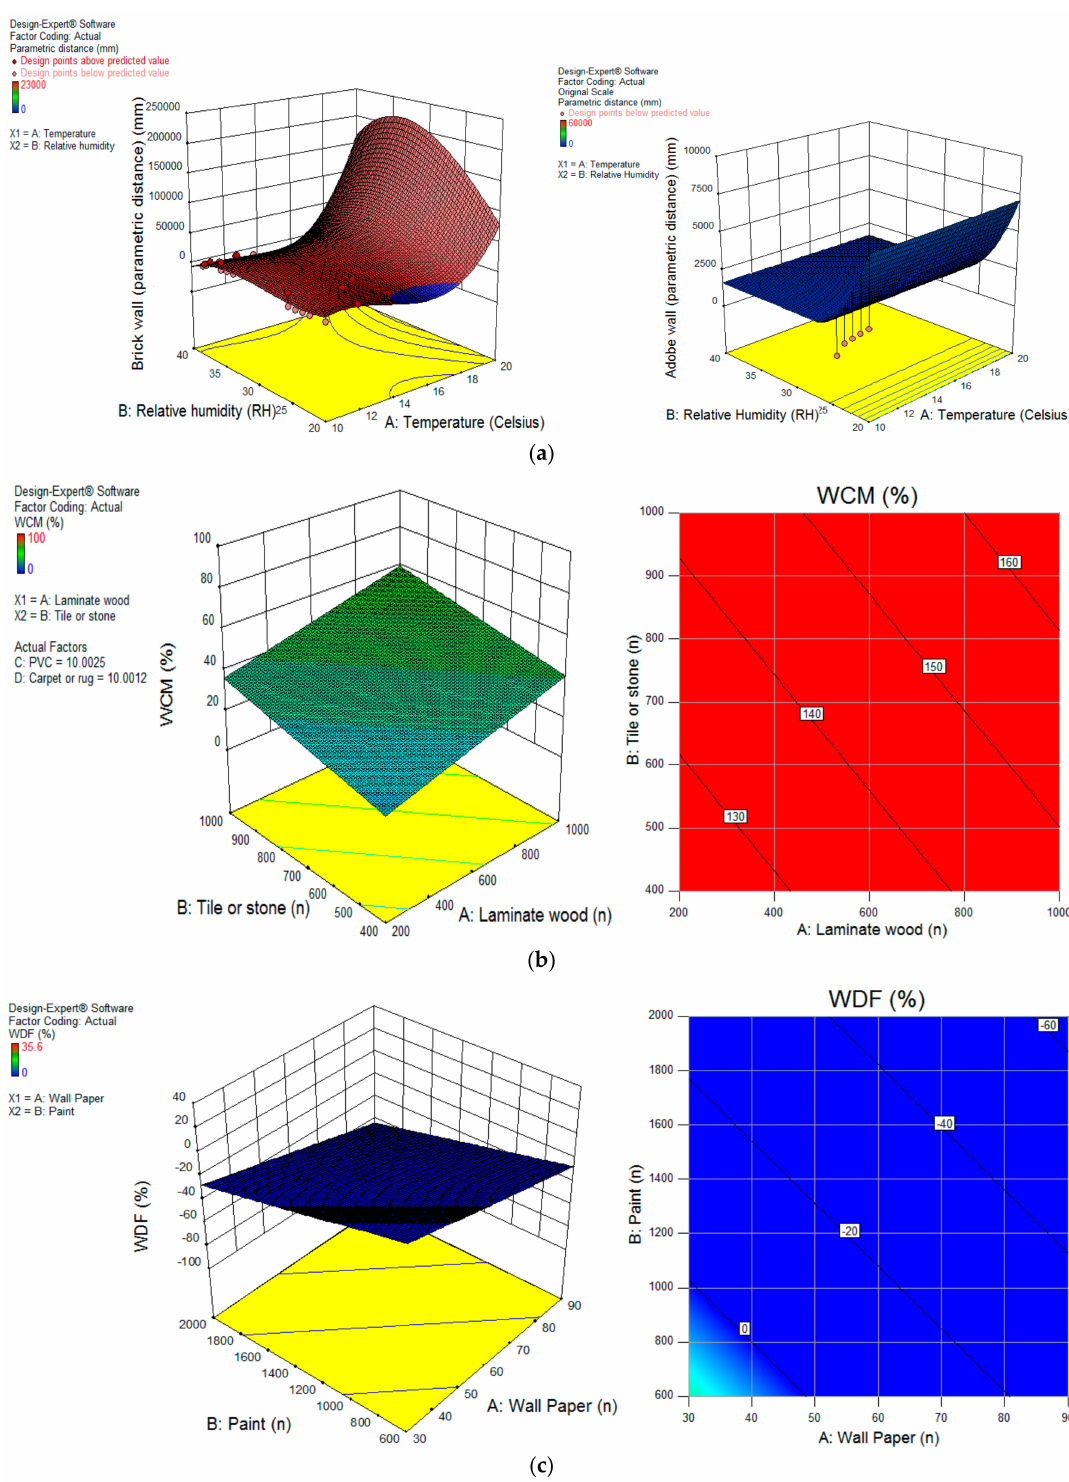
Figure 14. ( a ) Response surface plots of the mutual effect of the temperature and relative humidity through the apartment. Design-Expert Software 10. ( b ) Response surface plots of the mutual effect of the tile or stone and laminate wood on WCM. ( c ) Response surface plots of the mutual effect of the paint and wallpaper on